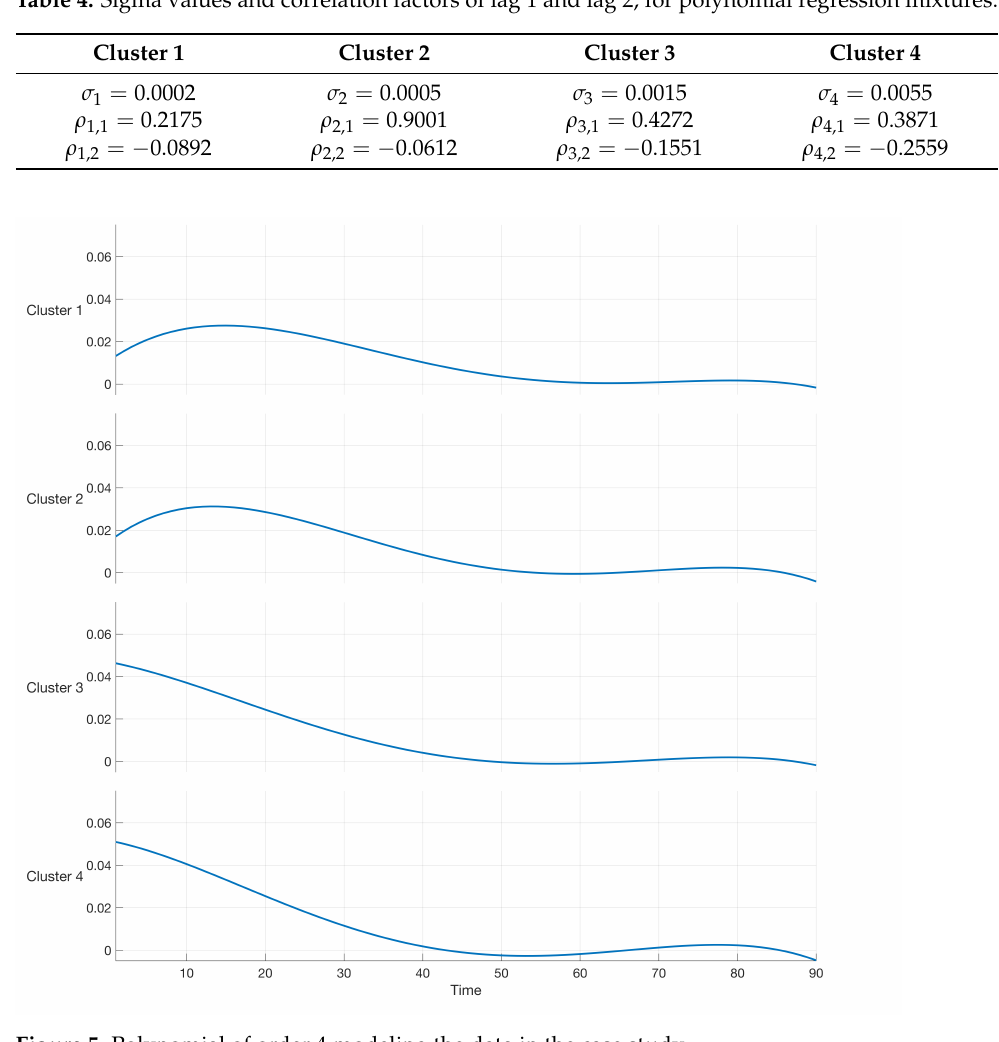
Figure 5. Polynomial of order 4 modeling the data in the case